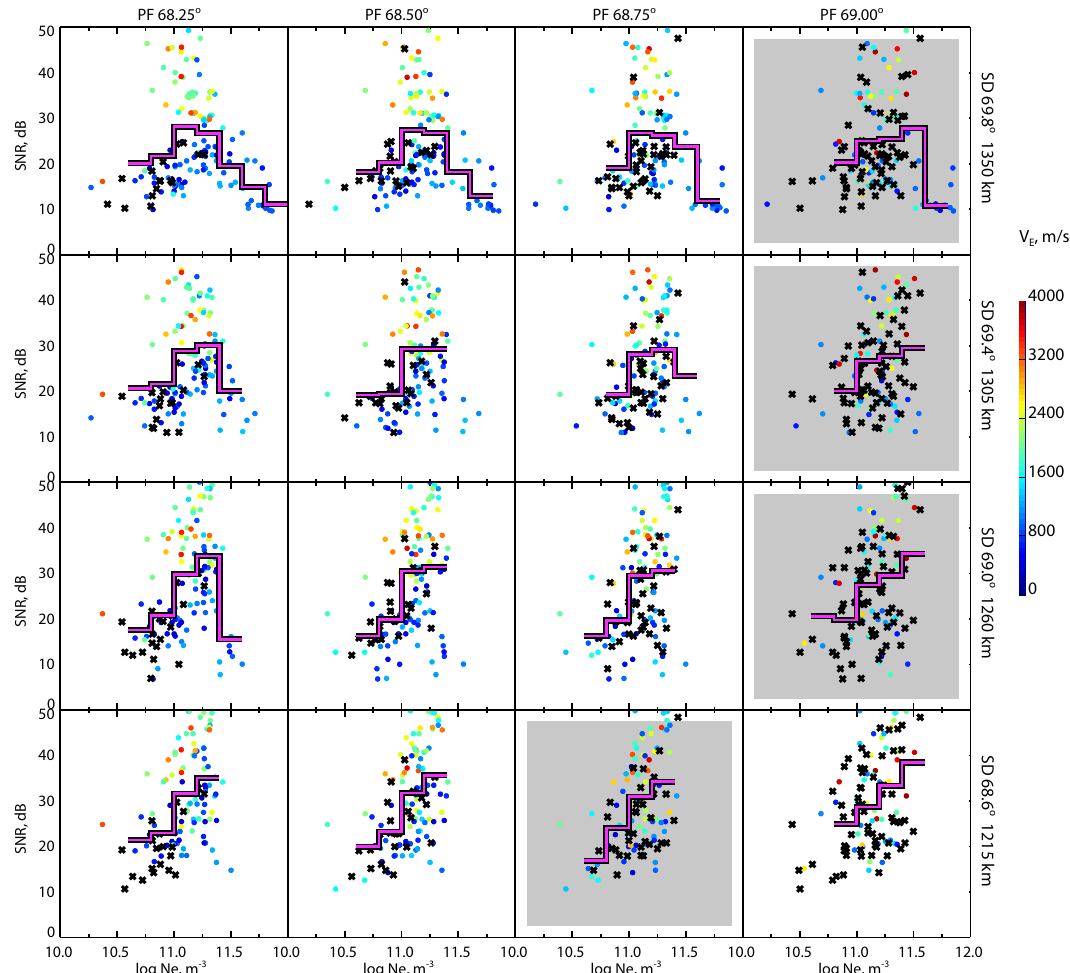
Figure 6. The same as Fig. 5 but versus the electron density N e and color-coded in the convection drift magnitude V E . The black crosses represent the data points without the V E